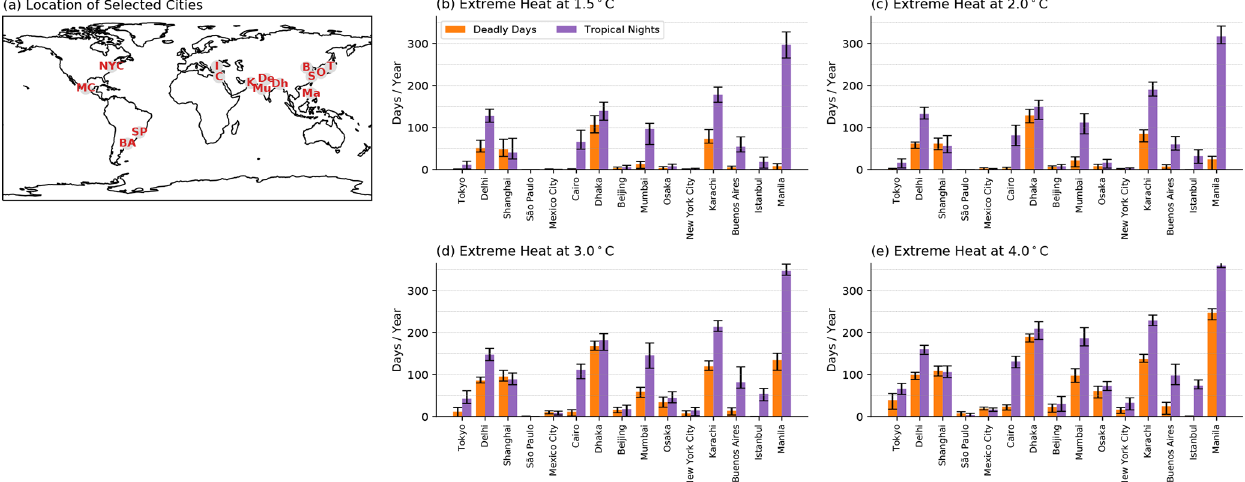
Figure 2. (a) Location of 15 largest cities in the world and the number of annual heat extremes at (b) 1.5, (c) 2.0, (d) 3.0, and (e) 4.0 ◦ C of global warming. Orange (purple) bars represent the ensemble average annual number of deadly days (tropical nights), averaged 5 years after each level of warming is exceeded. The number of heat extreme days are calculated by averaging a 3 × 3 land-only grid covering the selected city. Error bars represent the values of maximum and minimum ensemble